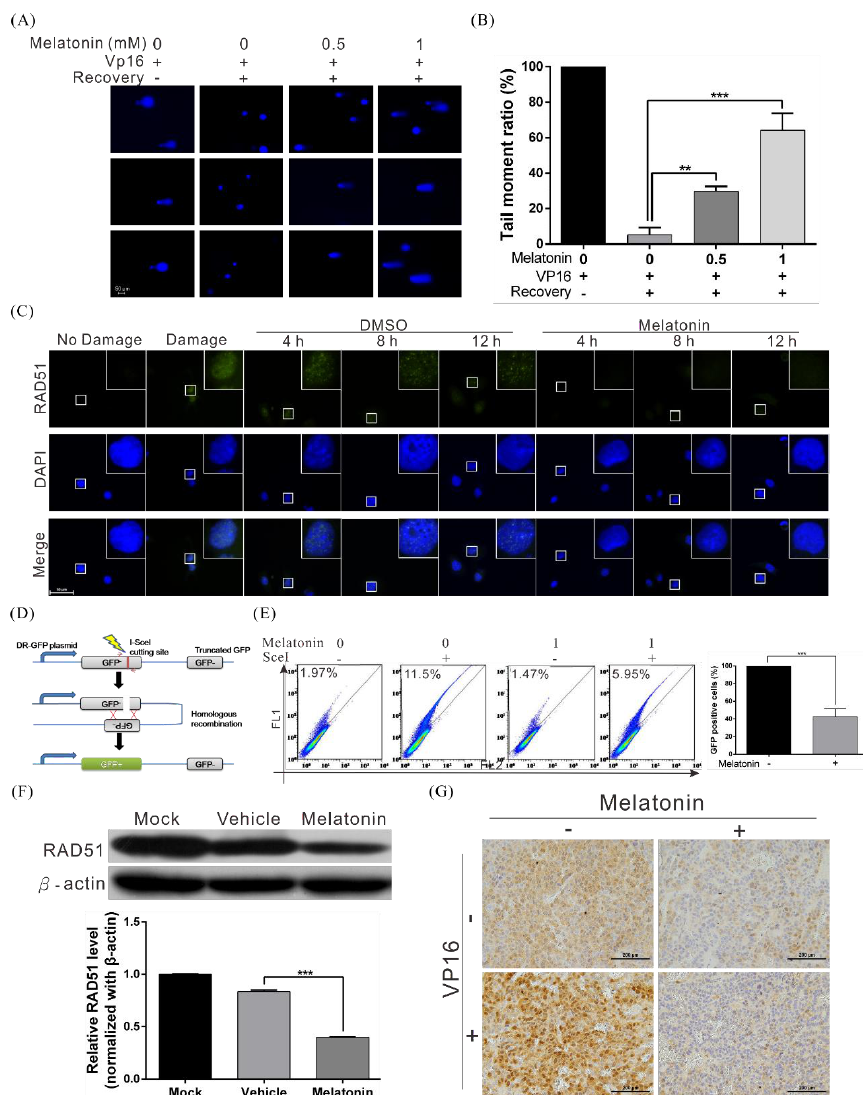
Figure 4. Melatonin suppressed the DNA repair capacity of HCC cells by inhibiting RAD51 expression. ( A ) A comet assay shows DNA repair activity after treatment with melatonin. Huh7 cells were treated with 200 µM etoposide (VP16) for 1 h, followed by treatment with different concentrations of melatonin in etoposide-free medium for 4 h. The cells were harvested and subjected to comet assays to detect DNA repair activity. The rows of panels present the results of three individual experiments. Quantification of cell repair activity is shown in ( B ). p < 0.01 (**), p < 0.001 (***). ( C ) Huh7 cells were treated with 200 μM etoposide (VP16) for 1 h to induce DNA damage, followed by recovery in medium with or without 1 mM melatonin. Cells were processed for immunofluorescence staining at various time points to detect the formation of Rad51 foci (green). Nuclei were stained with DAPI (blue). ( D ) A schematic representing the principle of the HR reporter assay. The DR-GFP system, which contains two mutated GFP genes (termed GFP − ) was applied to detect HR repair in human cancer cells. As the left GFP - gene contains an I- Sce I endonuclease site, expression of I- Sce I leads to a DSB that can be repaired by HR using the homologous region in the truncated GFP gene. The complete HR results in expression of a functional GFP (GFP + ) that can be detected by flow cytometry. ( E ) The results of flow cytometry indicate that melatonin significantly inhibited HR in HCC cells. ( F ) Western blot analysis of RAD51 in Huh7 cells treated with or without 1 mM melatonin for 48 h; β -actin was included as an internal control (upper panel). Quantitative results are shown in the lower panel. ( G ) Downregulation of RAD51 in mice xenografts treated with melatonin, as examined by